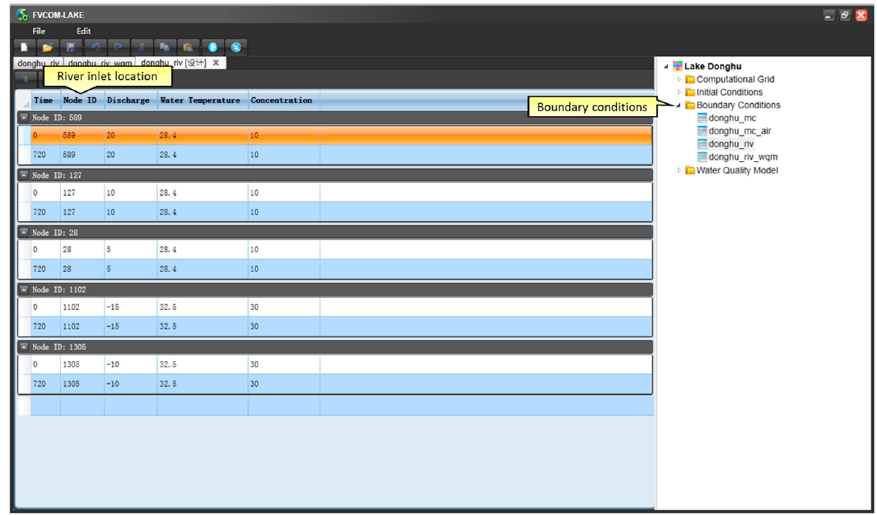
Figure 5. Interface used to set river boundary condition.